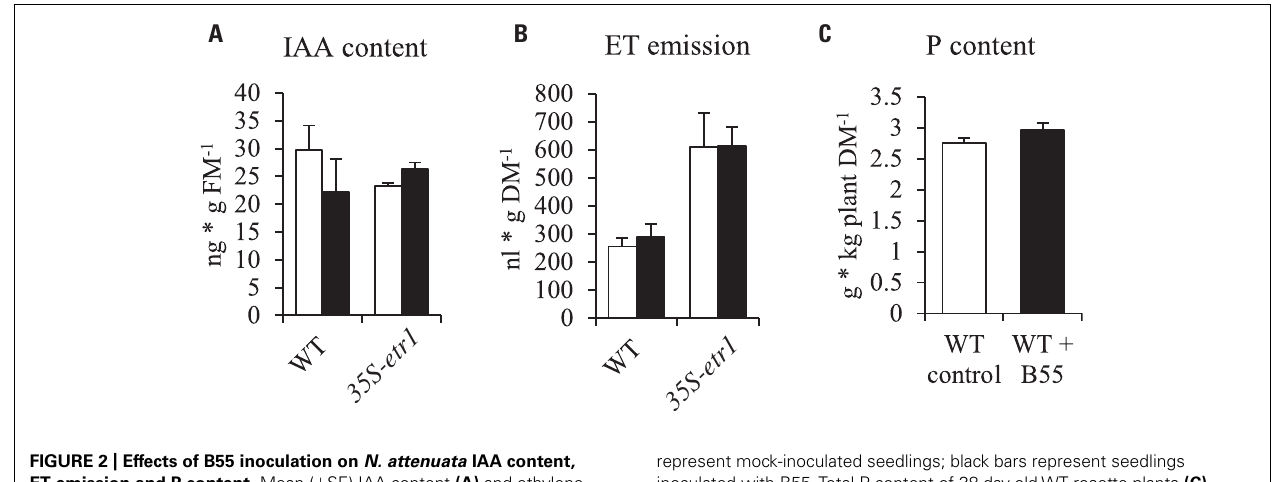
represent mock-inoculated seedlings; black bars represent seedlings inoculated with B55.Total P content of 38-day-oldWT rosette plants (C) . FM, fresh mass; DM, dry mass. n = 3 for IAA; 5 for ET; n = 6 for